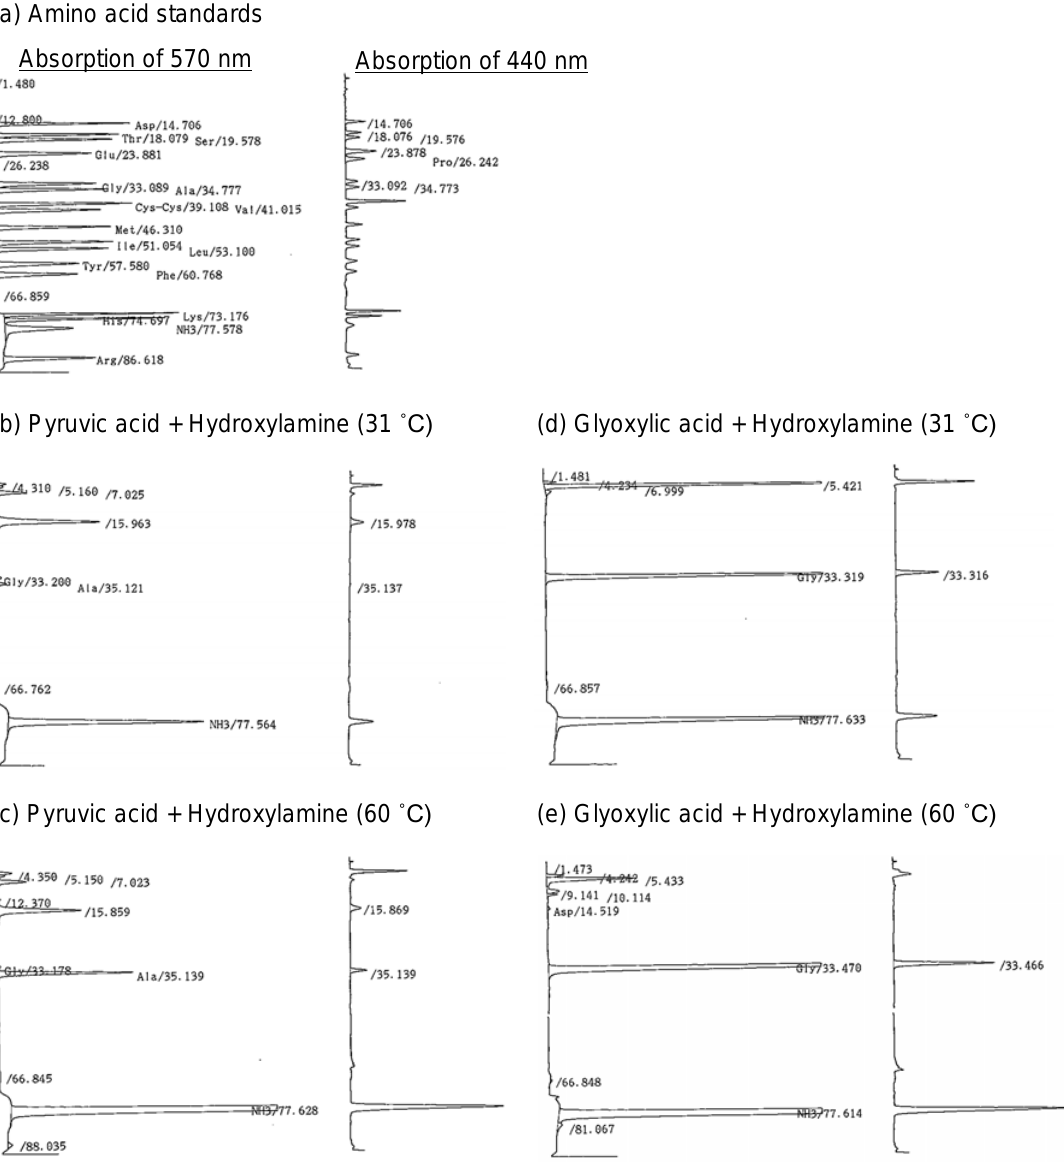
Figure 1. Chromatograms of amino-acid analysis. (a) Amino acid standards. (b)